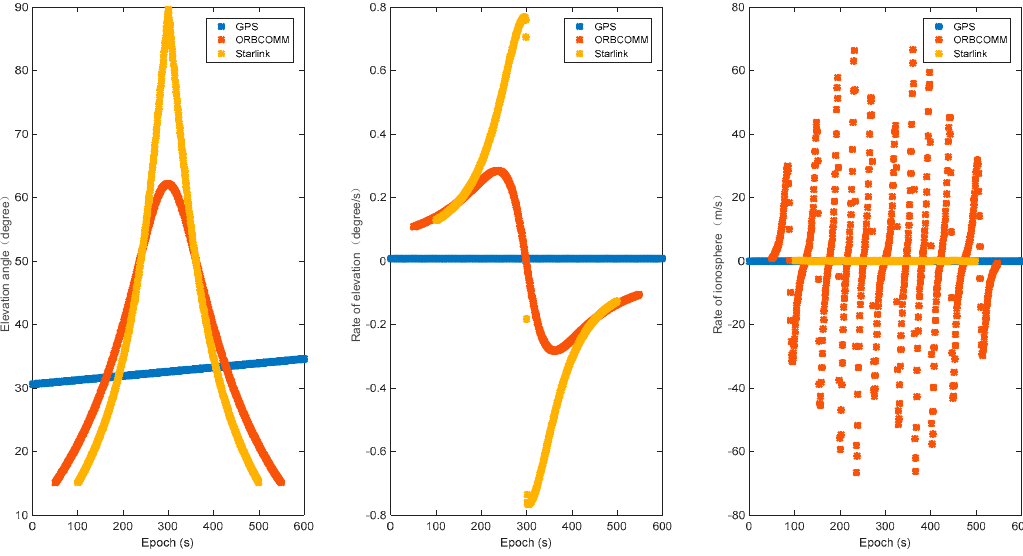
Figure 2. Ionospheric change rate of GPS, Starlink, Orbcomm.